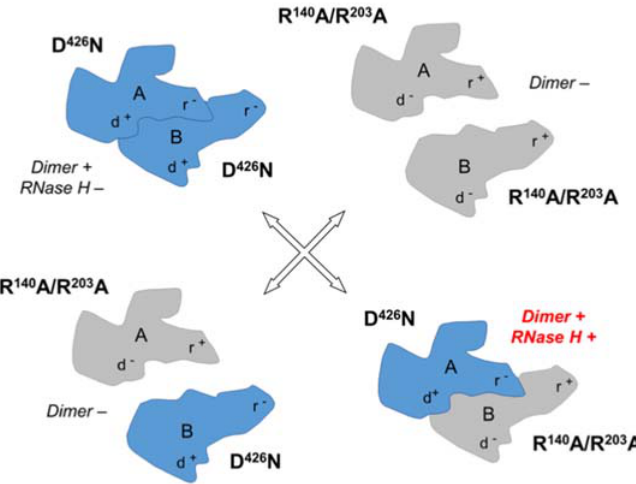
Figure 5. Phenotypic mixing strategy to determine the RNase H-competent Ty3 RT subunit. RNase H defective (D426N) and dimerization defective (R140A/R203A) mutant monomers are indicated in blue and grey, respectively. Notations d + and d − indicate a dimerization-competent and dimerization-incompetent subunit interface, while r + and r − denote RNase H-competent and RNase H-incompetent, respectively. Note that the d − mutant only prevents dimerization when in the A subunit position. When purified mutants are mixed, RNase H activity is only recovered in a reconstituted dimer whose subunit B contributes to RNase H activity.